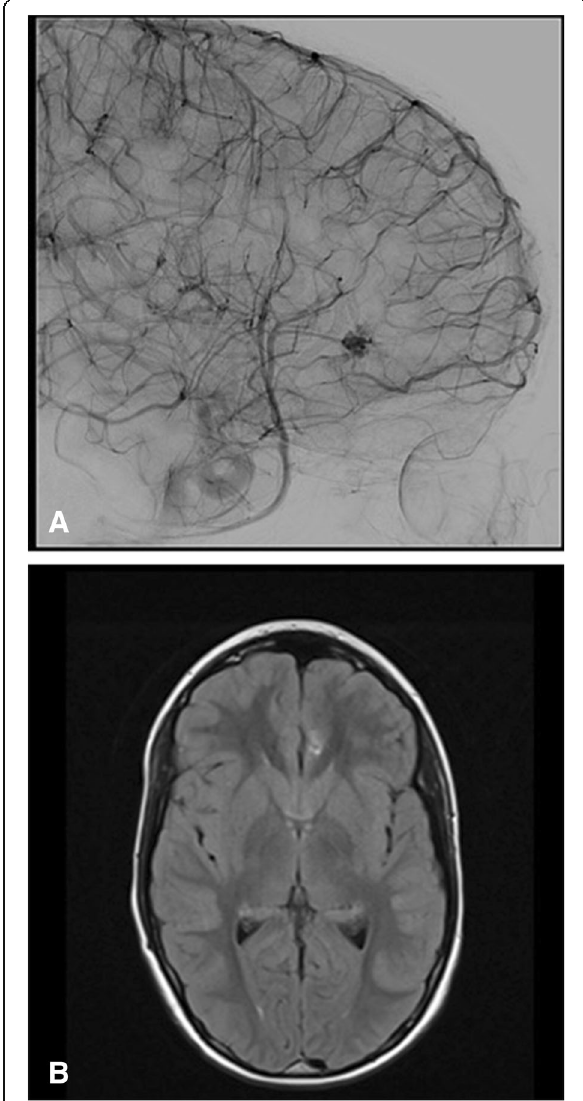
Fig. 9 A and B 12-year-old boy with heterozygous ENG mutation hereditary hemorrhagic telangiectasia and a cerebral capillary vascular malformation. A Late arterial phase lateral projection digital subtraction angiogram of the left internal carotid artery demonstrates a sub centimeter focus of ectasia and blush without arteriovenous shunting in the medial aspect of the left frontal lobe (arrow). B Axial FLAIR sequence showing corresponding focus